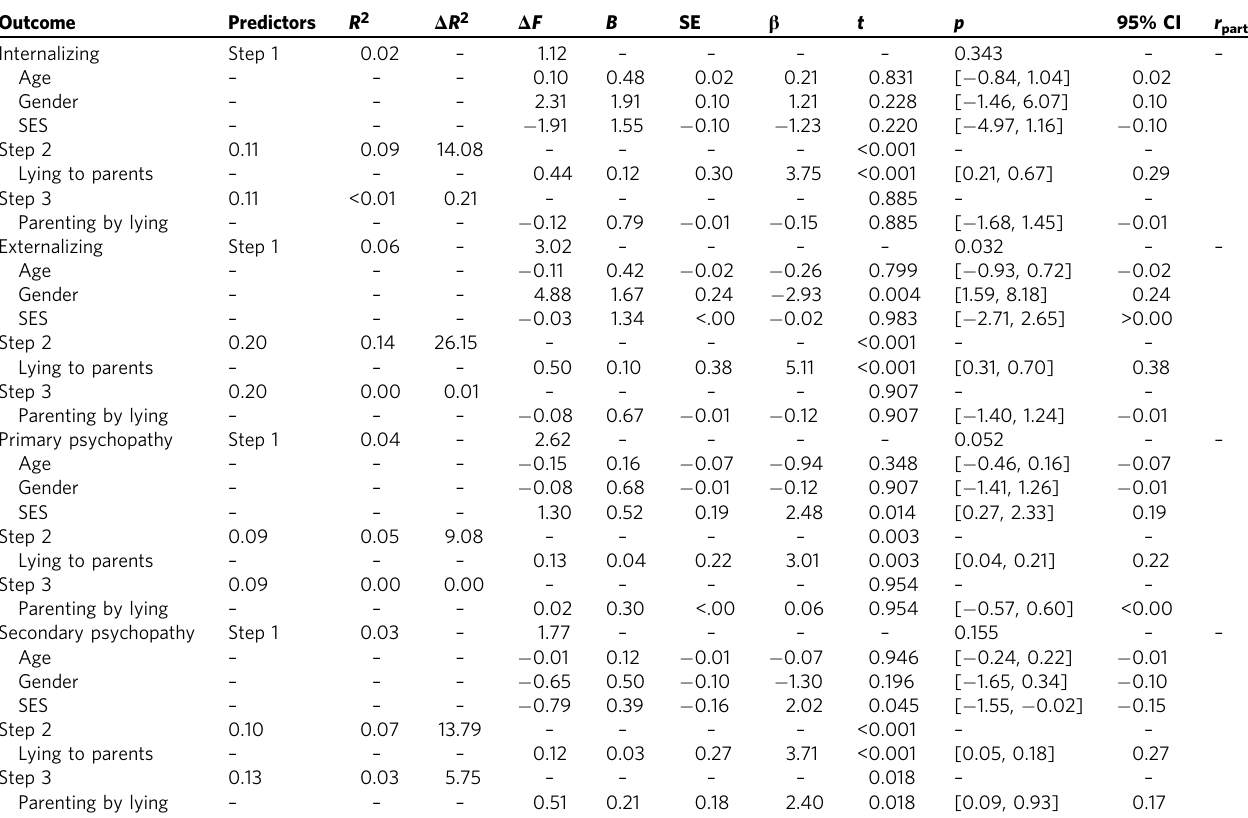
Table 2 Hierarchical regression for psychosocial problems as predicted by lying to parents and parenting by